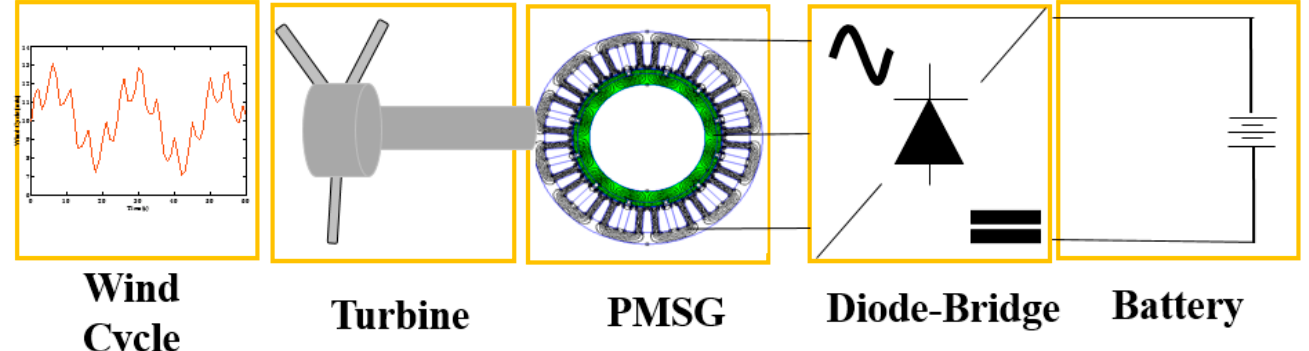
Figure 1. Simplified wind power conversion chain